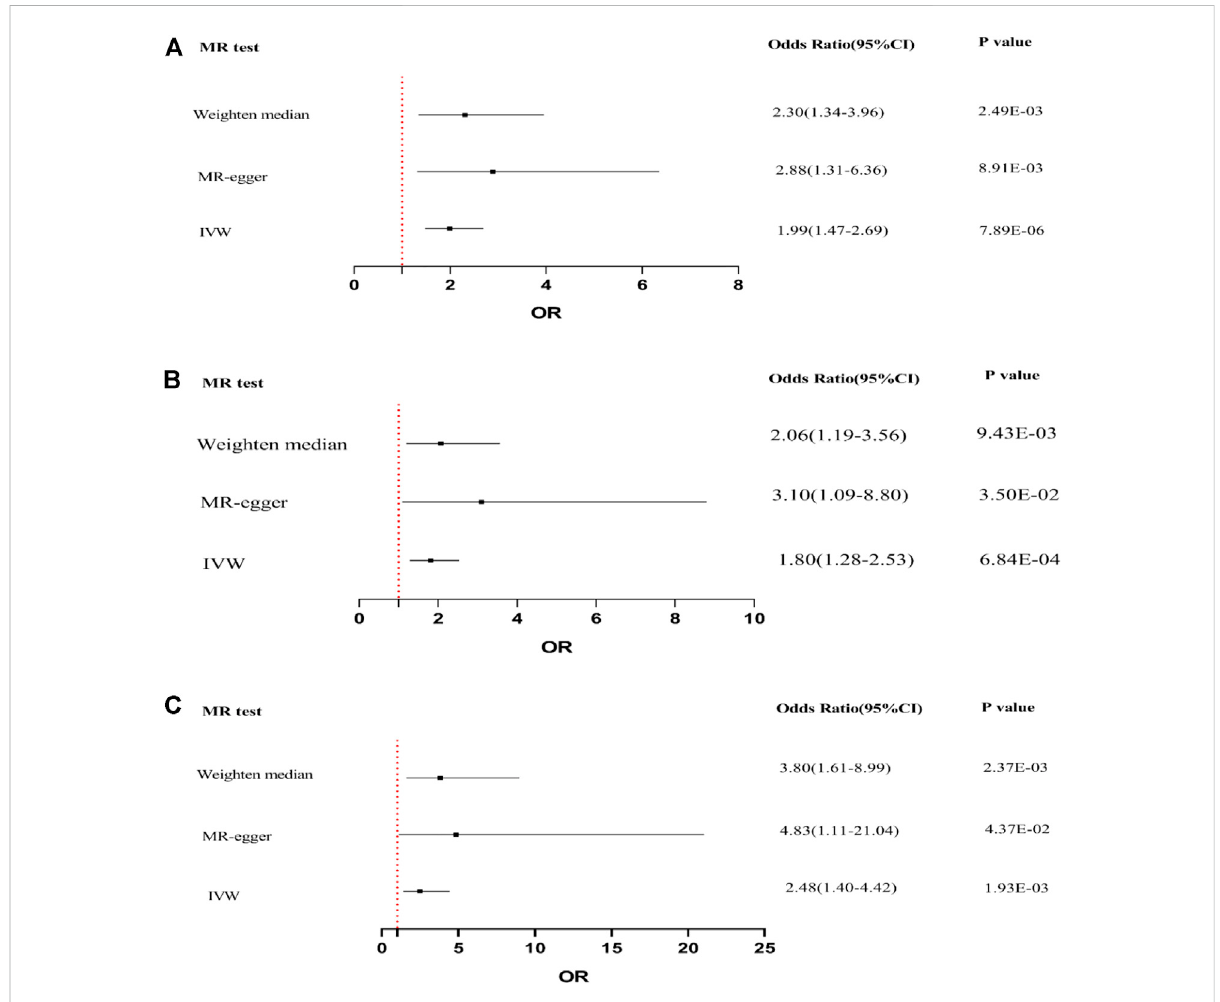
Forest plot to visualize causal effect of BMI, trunk fat mass, and WC on the risk of DKD by three methods. (A) Causal effect of BMI on DKD. (B) Causal effect of trunk fat mass on DKD. (C) Causal effect of WC on